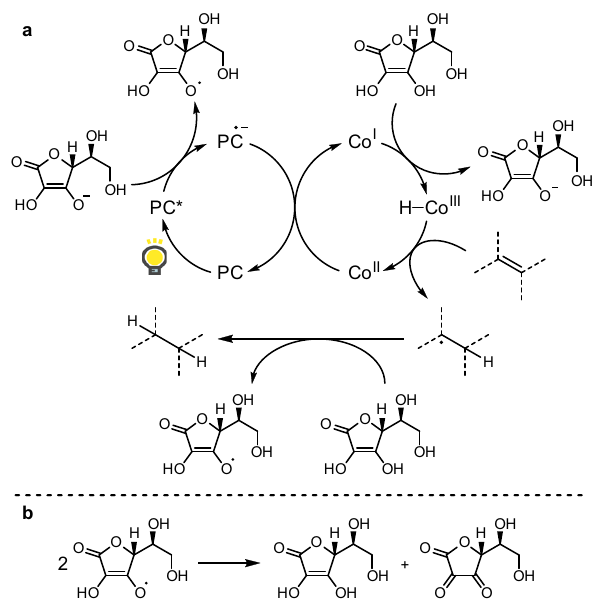
Fig. 2 Proposed mechanism for the HAT hydrogenation using ascorbic acid and a combined cobalt/photoredox catalytic system. a Hypothetical catalytic cycle of the silane- and peroxide-free HAT hydrogenation. b Disproportionation of ascorbic acid radicals; PC photoredox